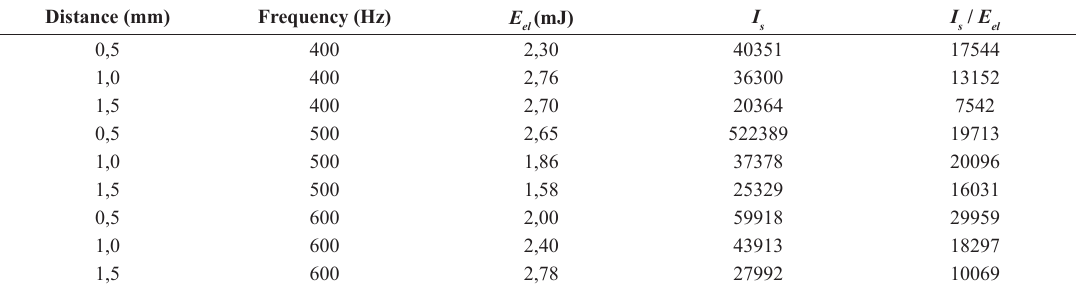
), Integral spectra intensity ( I el